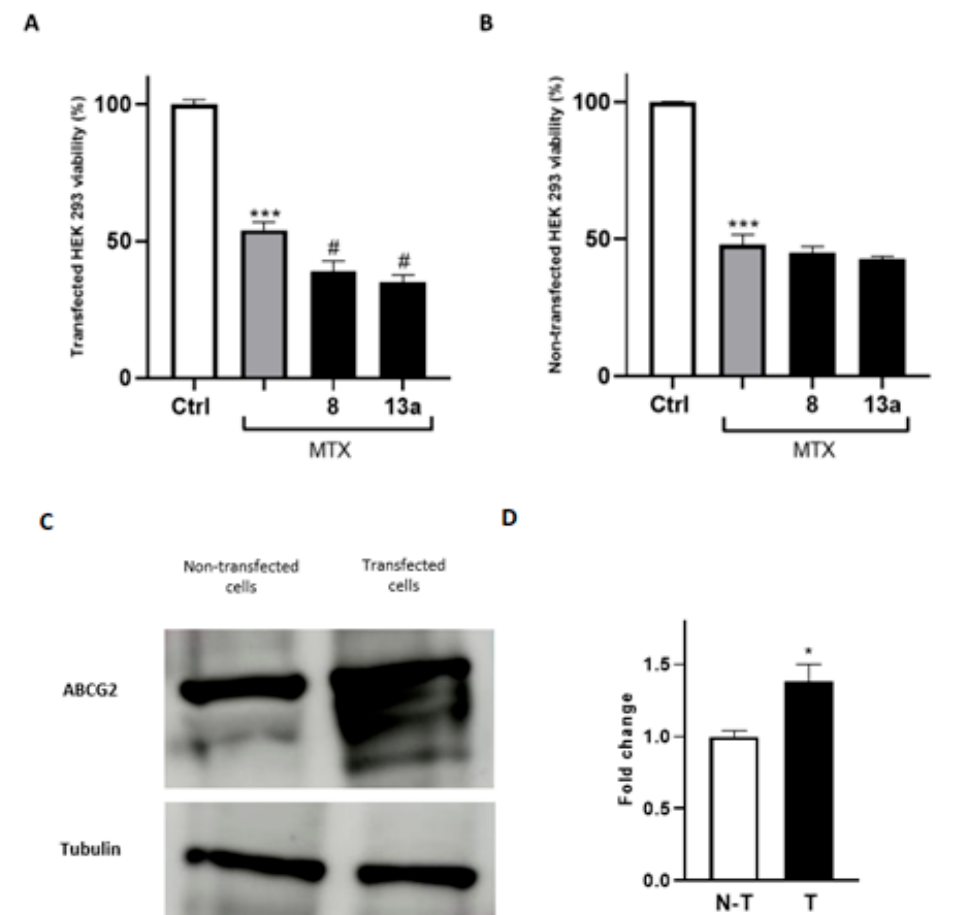
Figure 7. Cell viability assays using MTT conducted on the HEK293 wild type ( B ) and ABCG2- transfected cell lines ( A ). The EC 50 of MTX was administered. For each compound, three independent experiments were performed, and the standard deviation is expressed as error bars. *, *** denote p < 0.05 and p < 0.001 vs. the ctrl, respectively; # denotes p < 0.05 vs. MTX. ( C , D ): Western blot analysis of HEK-293 cells and HEK-293 transfected cells with the ABCG2 plasmid. Tubulin was used as a loading control. N-T indicates non-transfected cells, while T indicates transfected cells.